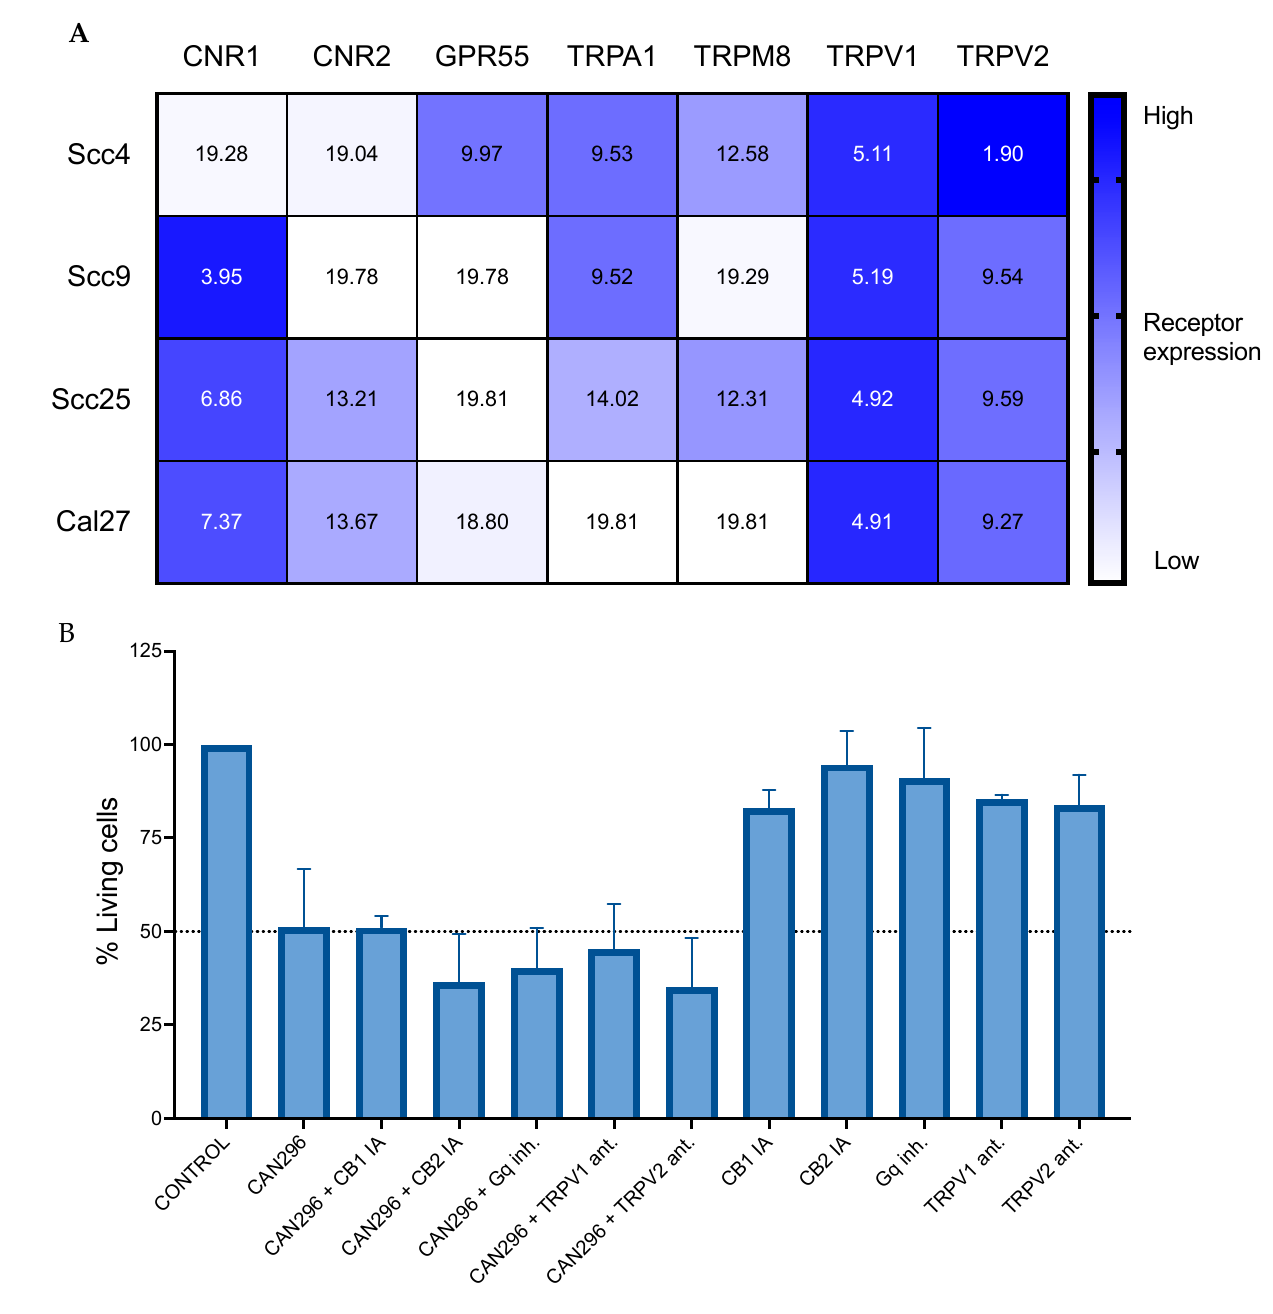
Figure 5. The cytotoxic effects of CAN296 are not mediated via common ECS receptors. ( A ) CNR1 (CB1), CNR2 (CB2), GPR55, TRPA1, TRPM8, TRPV1, and TRPV mRNA levels were evaluated by qPCR and normalized to the geomean of 7 house-keeping genes: BRAP, CSNK, cul3, EIF4, GUSB, SF3, and STK-1G. Expression levels are represented as Δ CT and color-coded (lower Δ CT values indicate higher receptor expression). Results are presented as a mean expression (n = 3). ( B ) Scc25 cells were left untreated or pretreated with endocannabinoid receptors antagonists for 1 h: 10 μ M Rimonabant—CB1 (IA), 10 μ M Am630—CB2(IA), 10 μ M BIM46187—Gq (inh.), 20 μ M AMG9810 TRPV1(ant.), or 20 μ M SET2—TRPV2 (ant.). Then, cells were treated for 24 with 4 μ g/mL CAN296 extract, and cell viability was evaluated by MTT relative to DMSO control. Data are reported as mean ± SE of % viable cells out of DMSO control untreated cells (n = 6). To identify endocannabinoid receptors’ involvement in the cytotoxic activity of the cannabis extract, we pretreated Scc25 cells with different inhibitors: the inverse (IA) to CB1 (Rimonabant) and CB2 (AM-630), the two receptors of the classic ECS, and the general inhibitor of G α q-proteins (BIM-46174); as well as antagonists (ant.) to TRPV1 (AMG 9810) and TRPV2 (SET2) that were highly expressed. None of the inhibitors signif- icantly rescued the cells from the cytotoxic effect of extract CAN296. (Figure 5B).